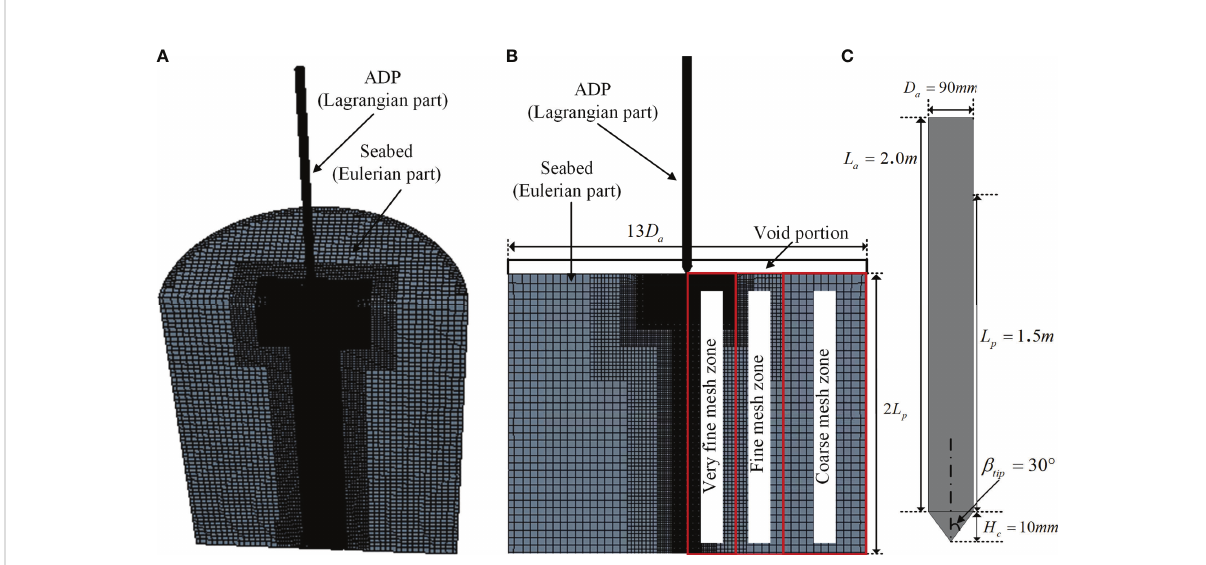
FIGURE 4 Typical mesh and geometry parameters used in coupled Eulerian – Lagrangian (CEL) analysis: (A) three-dimensional (3D) mesh; (B) side view; and (C) the geometry parameters of the auxiliary deployment part